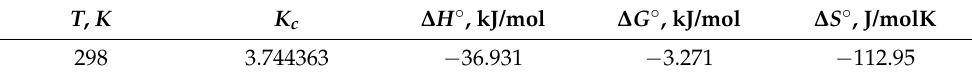
Table 2. Thermodynamic characteristics of fluoride ions sorption from solution by the bacterial cellulose-based modified